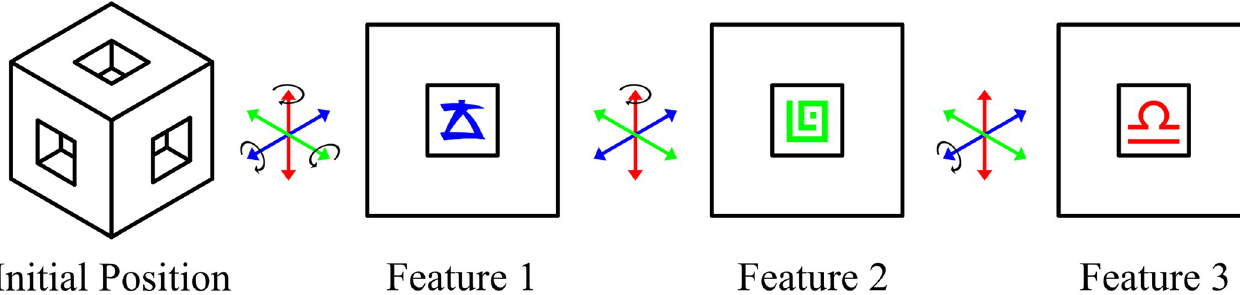
Fig 2. A graphical representation of a stimulus cube. The stimulus cube initially spawns in a position where none of the three features can be seen. By rotating the cube each of the three features can be seen in turn. The wells prevent more than one feature from being visible at a time. Note that opposing sides of the cube display the same